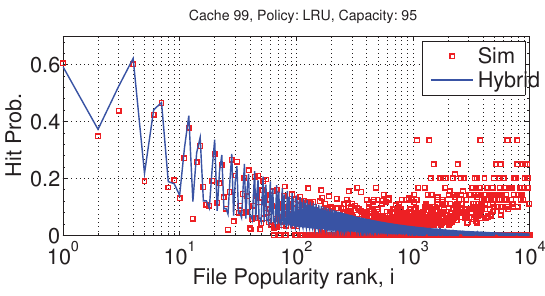
Figure 8: Hybrid approximation on a large random network of N = 10 2 caches, K = 10 4 , C ∈ [50 , 150].